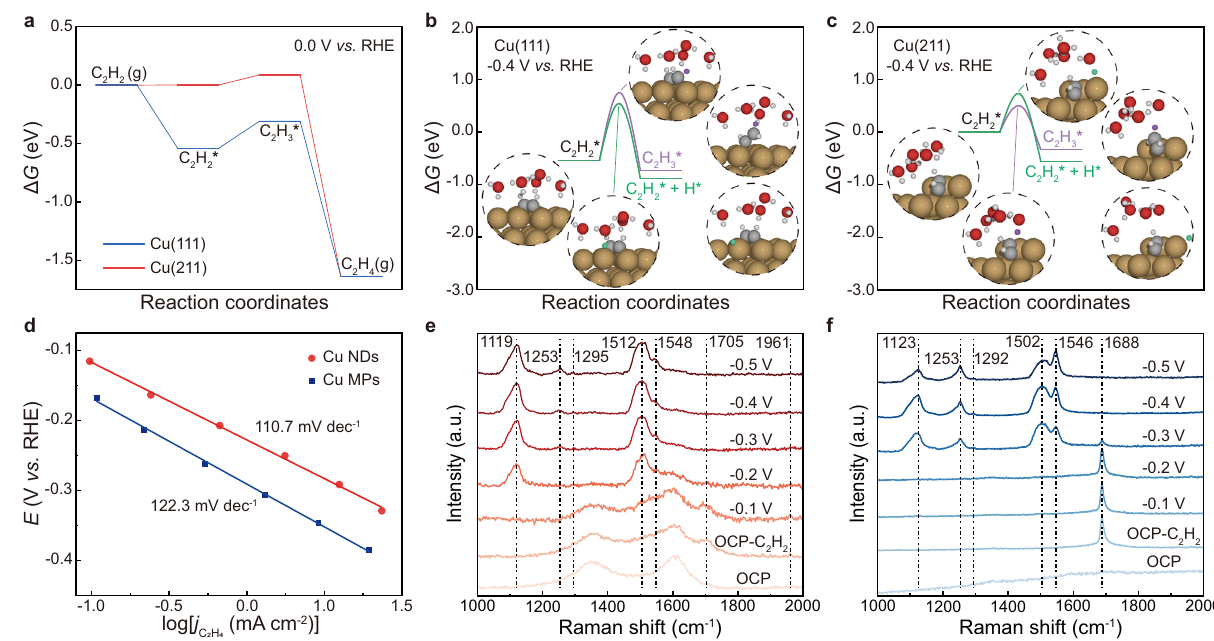
Fig. 3 | DFT theoretical calculations and in situ electrochemical Raman study. a Free energy diagram of reducing C 2 H 2 on Cu (111) and Cu (211) surfaces. b , c Comparison between the barriers of forming C 2 H 3 * and H* on b Cu (111) and c Cu (211) surfaces. All energies were referenced to C 2 H 2 and a